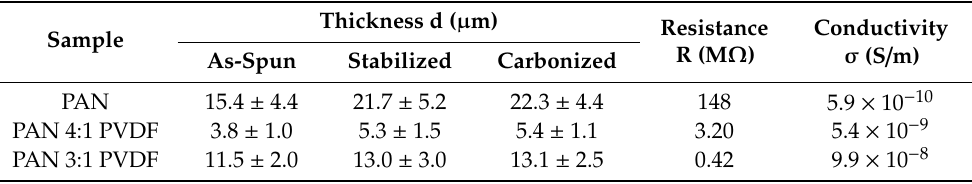
Table 1. Exact thickness values as shown in Figure 3 for all nonwovens as well as resistances and conductivities of all carbonized nonwovens at 25 ◦ C.